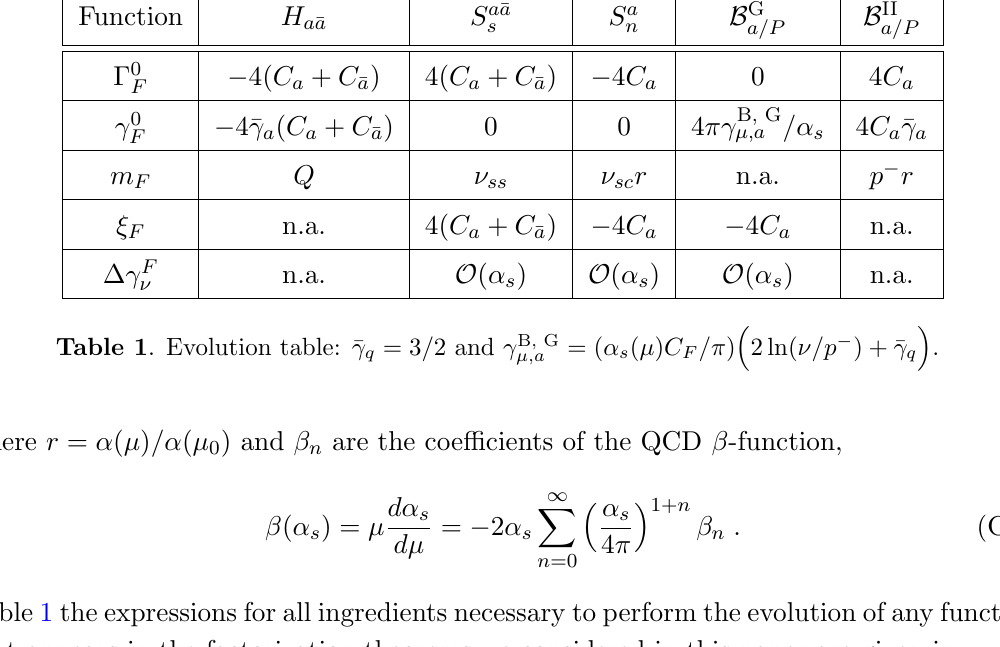
Table 1 . Evolution table: (cid:22) (cid:13)